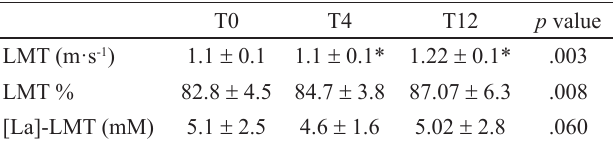
4. Mean ± standard deviation of the lactate minimum test (LMT) intensity, LMT intensity expressed as percentage of the maximal effort of 200m (LMT%), and blood lactate concentration corresponding to the LMT intensity ([La]-LMT) during T0, T4, and T12.